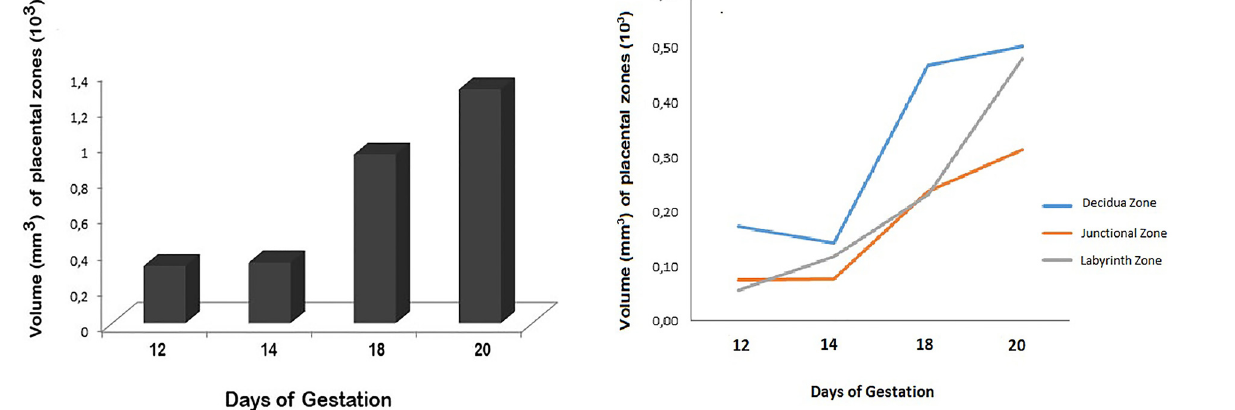
Figure 2. Total volume of the rabbit placenta (mm 3 ) from the 12 days to the 20 days of gestation.